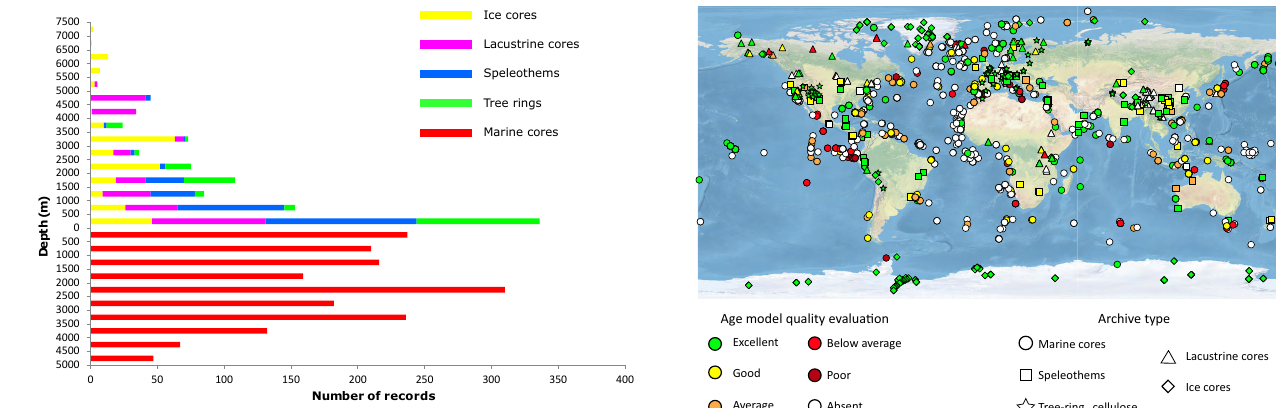
Figure 7. Location of lacustrine (triangles), speleothems (squares) and marine records (circles) where chronological information is available, and with quality flags for age model quality